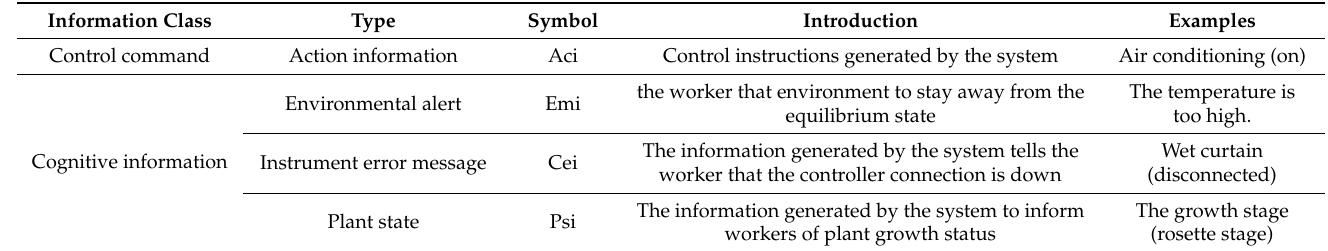
Table 3. Output information